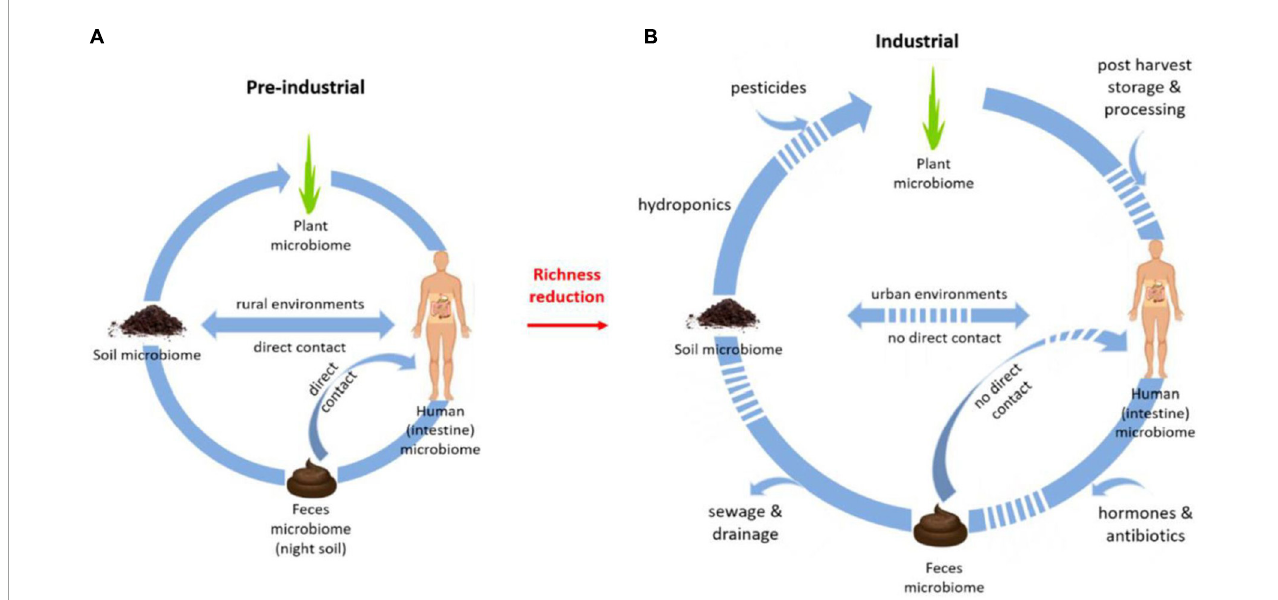
FIGURE6 Illustration of how the microbiota in our environment can influence the human intestine microbiome, through direct contact with soil and faeces as well as through food (quality). (A) A cycle for pre-industrial microbiota. (B) A cycle for industrial microbiota. Source: From Blum et al. (98).